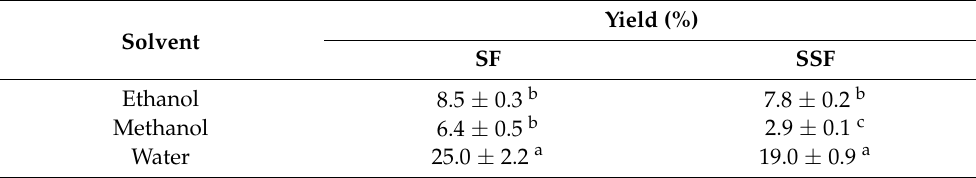
Table 1. The extraction yields of fresh and steamed Sargassum fusiforme